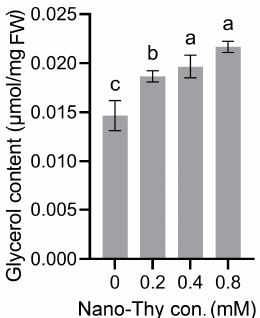
Figure 9. The effect of Nano-Thy on the glycerol content in the mycelia of B. cinerea . Different lowercase letters indicated significant difference among treatments (ANOVA, n = 3, p < 0.05).